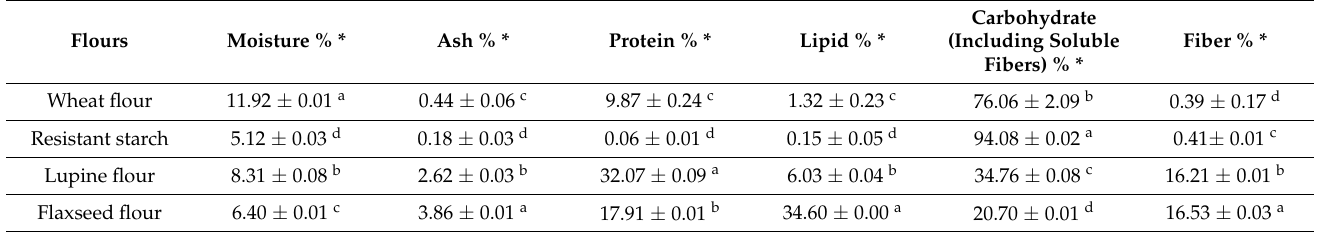
Table 4. The percentage of moisture, ash, protein, lipid, carbohydrate (including soluble fibers) and insoluble fibers in wheat flour, resistant starch, lupine flour and flaxseed flour.